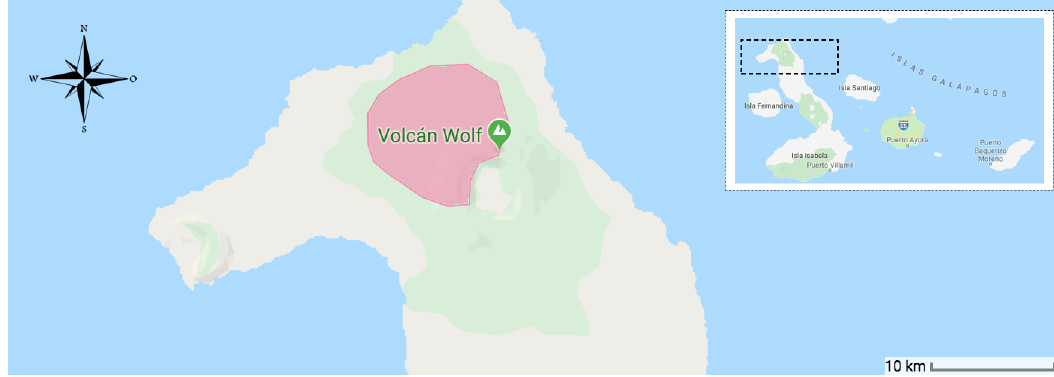
Figure 1. Map of the monitoring